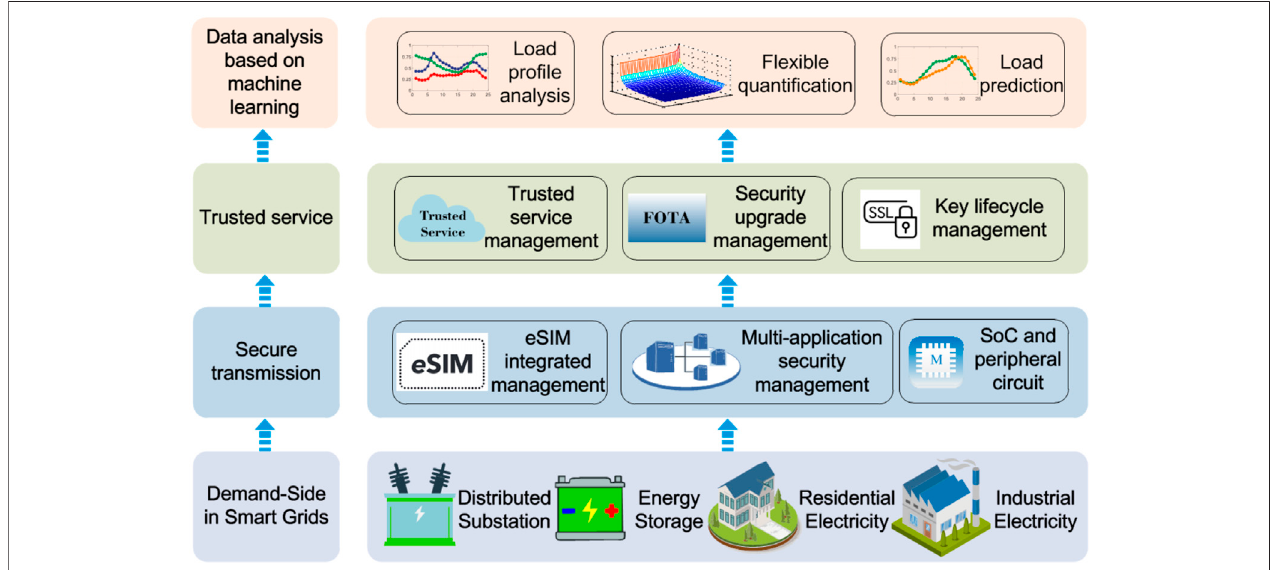
FIGURE 2 | Overall technical framework of secure transmission and intelligent analysis of demand-side data in smart grids based on NB-IoT.